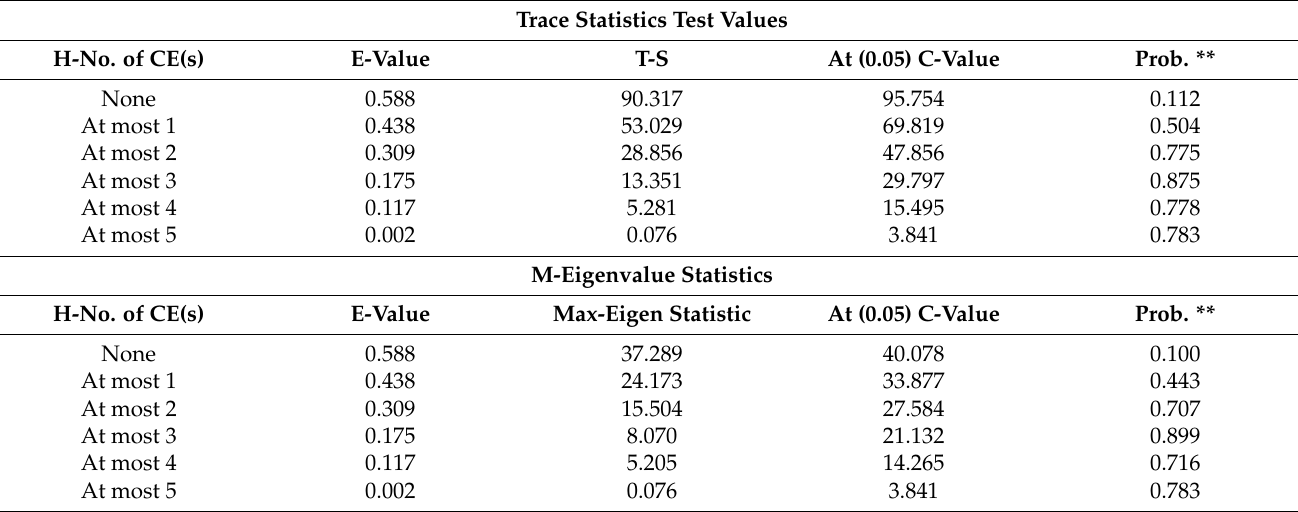
Table 4. Outcomes of Johansen cointegration technique. Trace Statistics Test